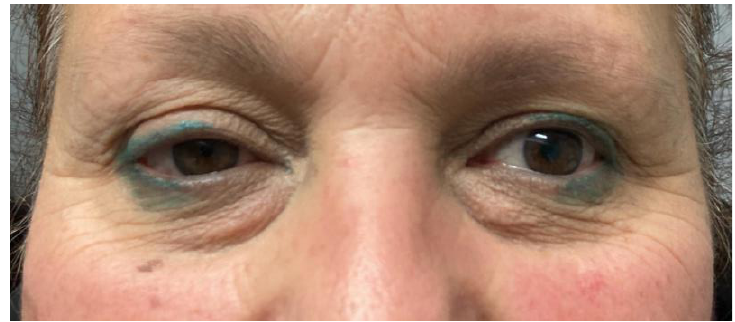
Figure 6. Horner syndrome.